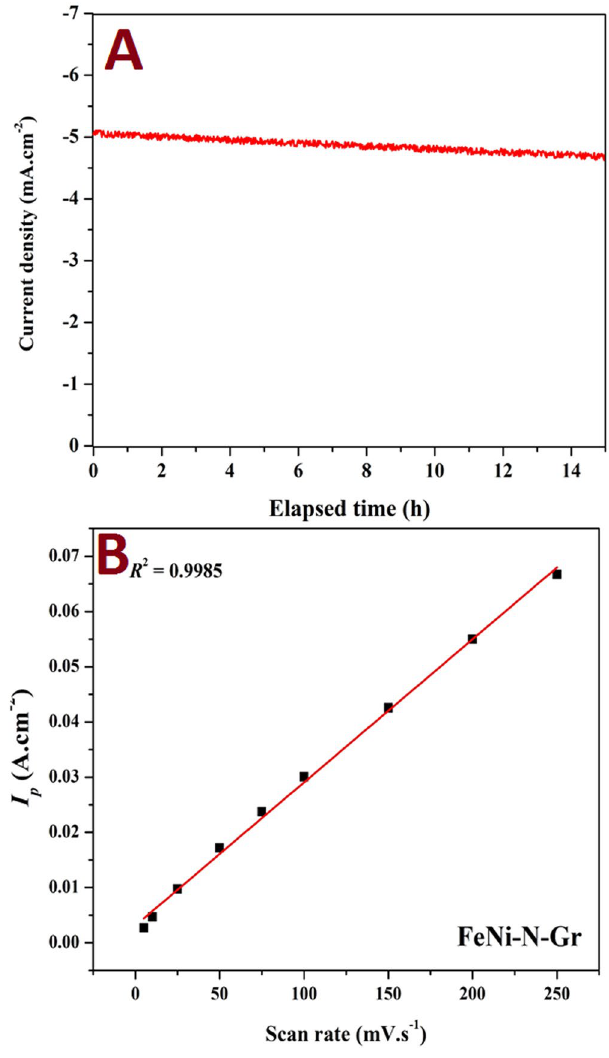
Figure 6. ( A ) Chronoamperometry test for the introduce nanocomposite in 0.5 H 2 SO 4 at room temperature and ( B ) Peak currents versus scan rate for the introduced FeNi-N-Gr electrode in 0.5 M H 2 SO 4 at room